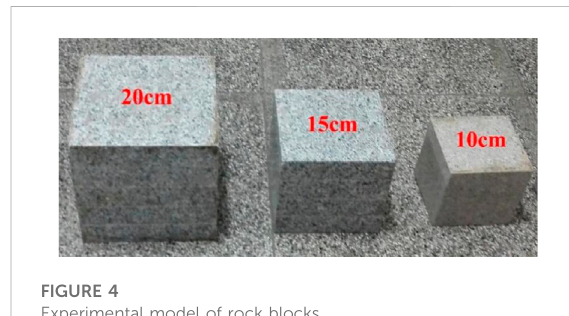
FIGURE 4 Experimental model of rock blocks.